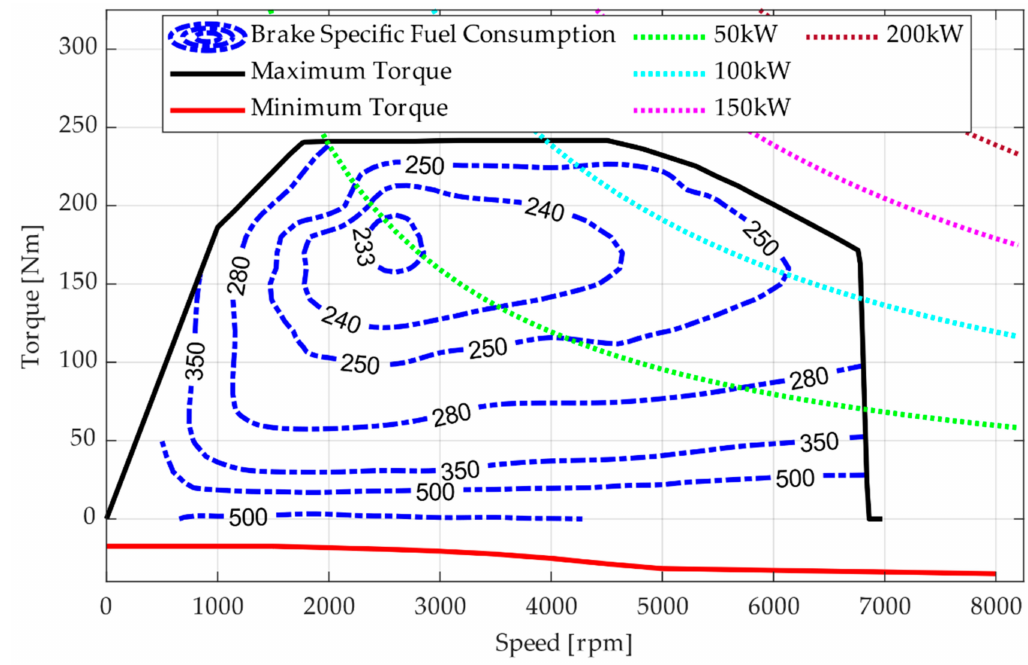
Figure 3. Fuel consumption (g / kWh) of a petrol engine, represented as a function of the engine speed and engine torque. For confidentiality reasons, the values are